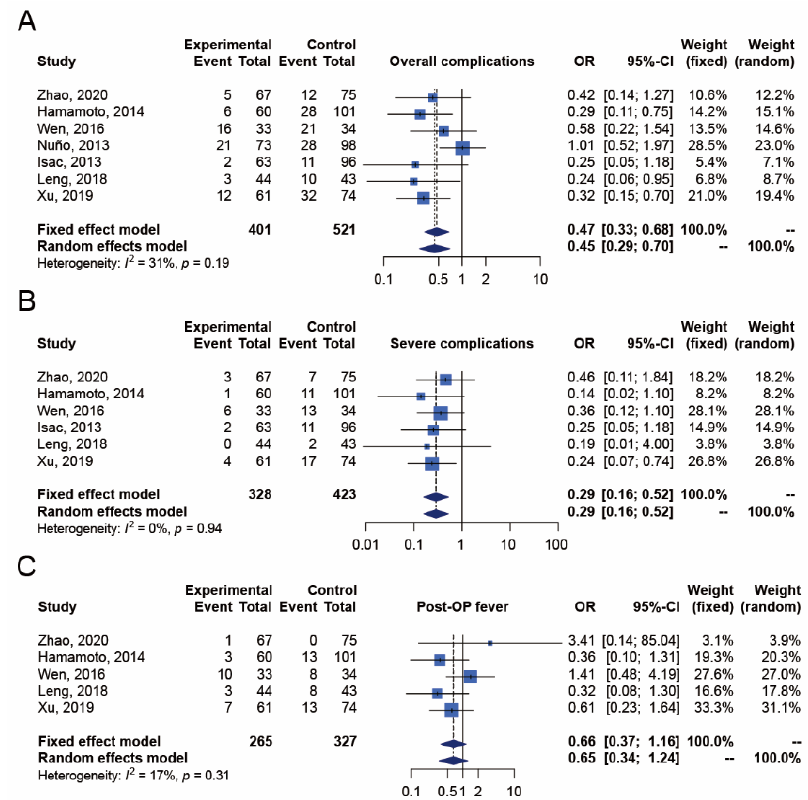
Figure 3. Meta-analysis of safety outcomes, including ( A ) overall complications [17–23], ( B ) severe complications [17–19][21–23], and ( C ) postoperative fever [17-19][22,23] between ECIRS and PCNL groups.